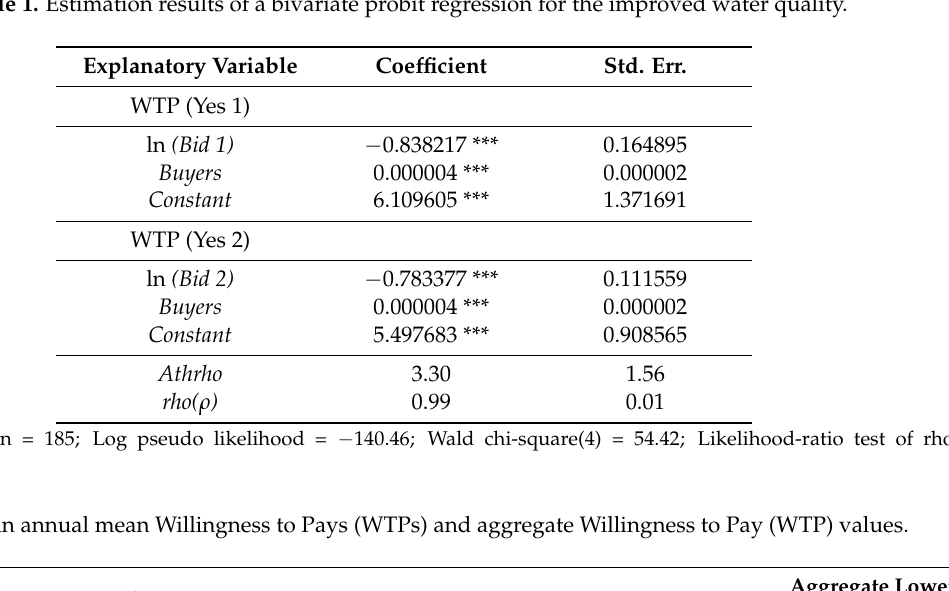
Table 1. Estimation results of a bivariate probit regression for the improved water quality.